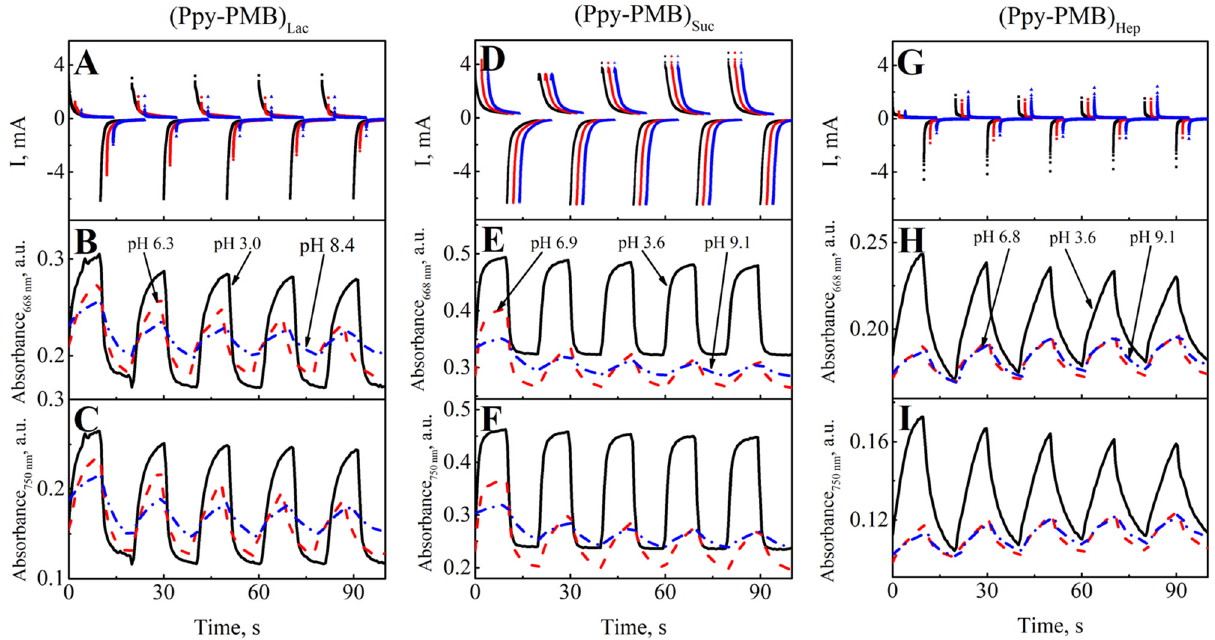
Figure 5. Evaluation of Ppy-PMB layers during potential pulsation. ( A )—potential pulse sequence of (Ppy-PMB) Lac , ( D )—(Ppy-PMB) Suc , ( G )—(Ppy-PMB) Hep (pH 6 offset 2, pH 9 offset 4). Changes of absorbance at different pH values (at pH 3.0–4.0, pH 6.0–7.0, and pH 8.0–9.0): for (Ppy-PMB) Lac at ( B )— λ = 668 nm, and ( C )— λ = 750 nm; for (Ppy-PMB) Suc at ( E )— λ = 668 nm, and ( F )— λ = 750 nm; and for (Ppy-PMB) Hep at ( H )— λ = 668 nm and ( I )— λ = 750 nm. Potential pulses were +0.8 V and − 0.8 V. Duration of the pulse was 10 s. Each potential was repeated 5 times. The dependence of optical absorbance was measured in BRB with 0.1 M of KCl solution. WE—glass/ITO electrode with Ppy-PMB layer, CE—platinum wire, RE—Ag/AgCl (3M KCl)